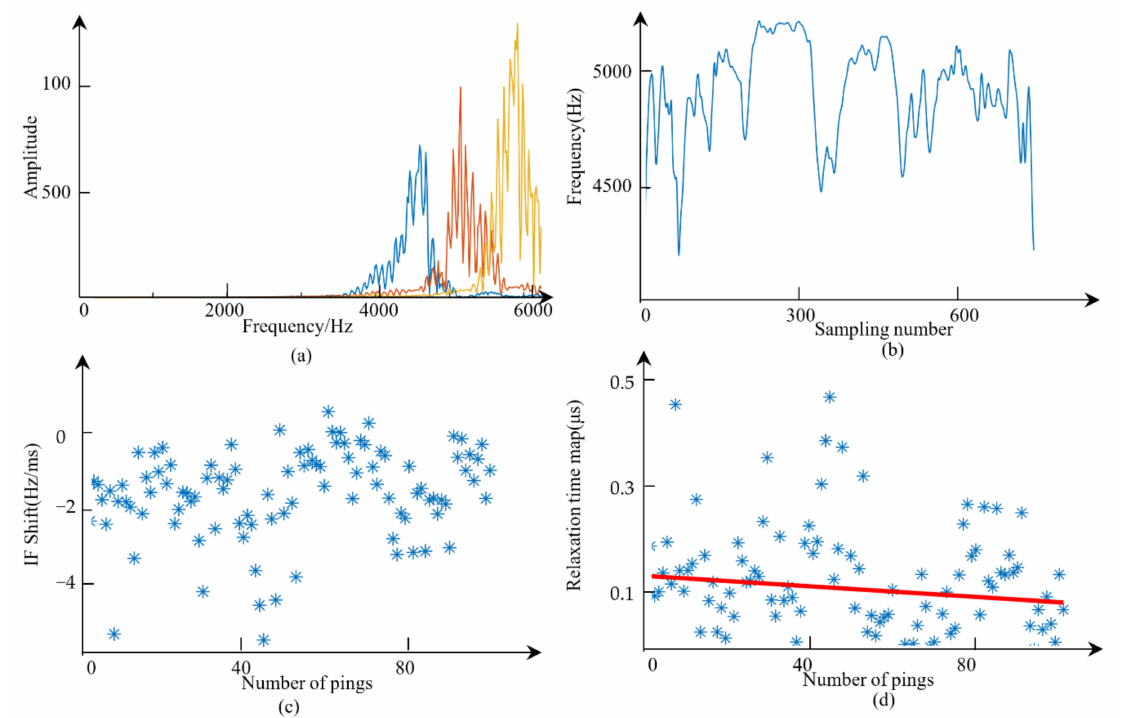
Figure 8. Illustration of VMD, IF series, and the relaxation time map. ( a ) The spectral overlap situation after VMD. ( b ) The IF series data of one ping. ( c ) The IF shift data of 101 pings. ( d ) The robust line fitting based on a relaxation time